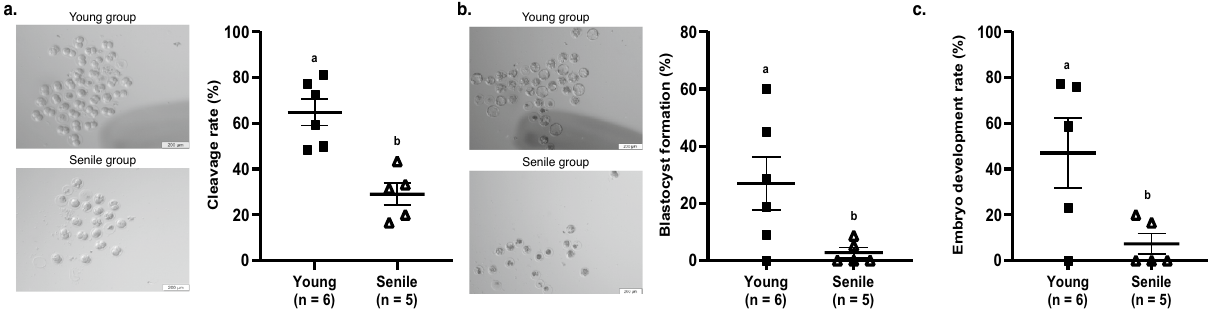
Figure 2. In vitro embryo development. Image and chart of cleaved embryos from the young and senile group (number of cleaved embryos/number of total structures × 100; a ). Image and chart of blastocyst from the young and senile group (number of blastocysts/number of total structures × 100; b ), and embryo development rates (number of blastocysts/number of cleaved embryos × 100; c ) from young and senile groups. In the young group: 185 total structures (presumed zygotes) from 6 pregnant dams (30.8/pregnant dam), 122 cleaved embryos from 6 pregnant dams (20.3/pregnant dam), and 61 blastocysts from 6 pregnant dams (10.1/pregnant dam). In senile group: 107 total structures from 5 pregnant dams (21.4/pregnant dam), 27 cleaved embryos from 5 pregnant dams (5.4/pregnant dam) and 3 blastocysts from 5 pregnant dams (0.6/pregnant dam). The evaluations were performed in stereomicroscope (Olympus SZ61, Olympus ® , Tokyo, Japan) at ×60 magnification. Different superscript letters in each bar represent p < 0.05, as indicated by statistical T-test.